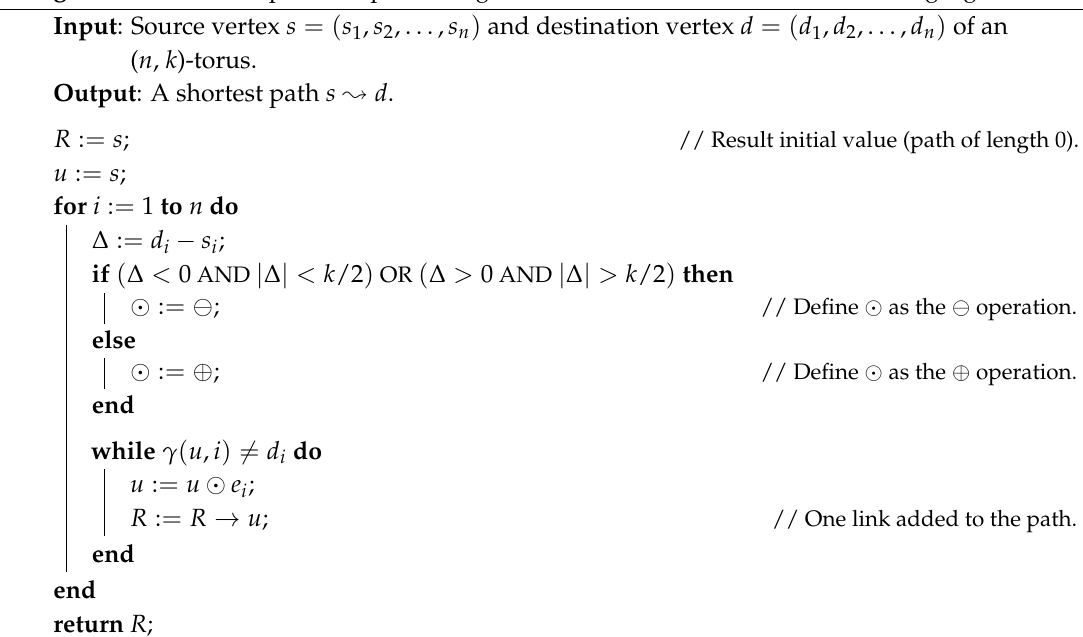
Algorithm 1: Point-to-point simple routing in a torus with a dimension-order routing